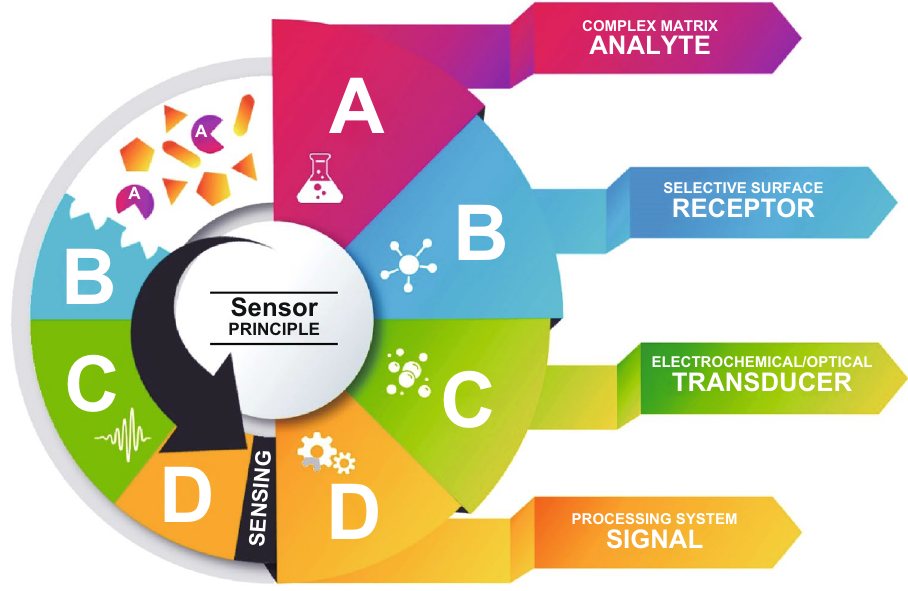
Fig. 3 General scheme of a sensor. The interaction of an analyte with the selective receptor, coupled to a transducer, transfers a measurable sig- nal to processing